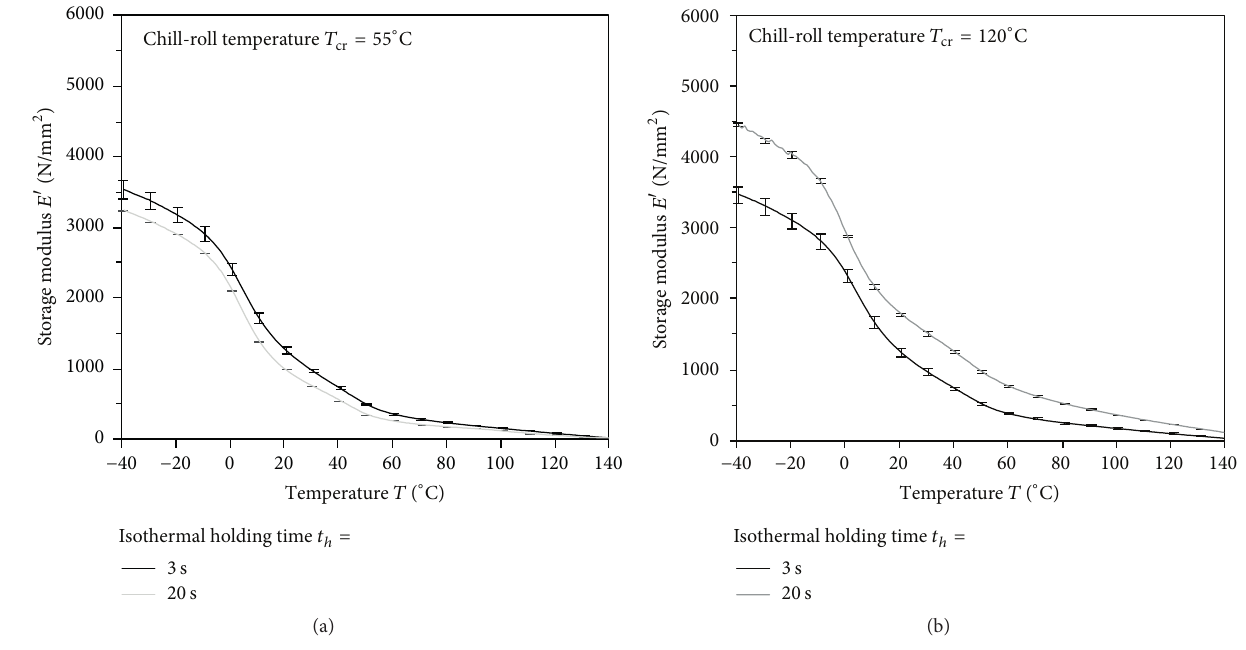
Figure 13: Storage modulus of extruded foils manufactured at chill-roll temperature of 55 ∘ C (a) and 120 ∘ C